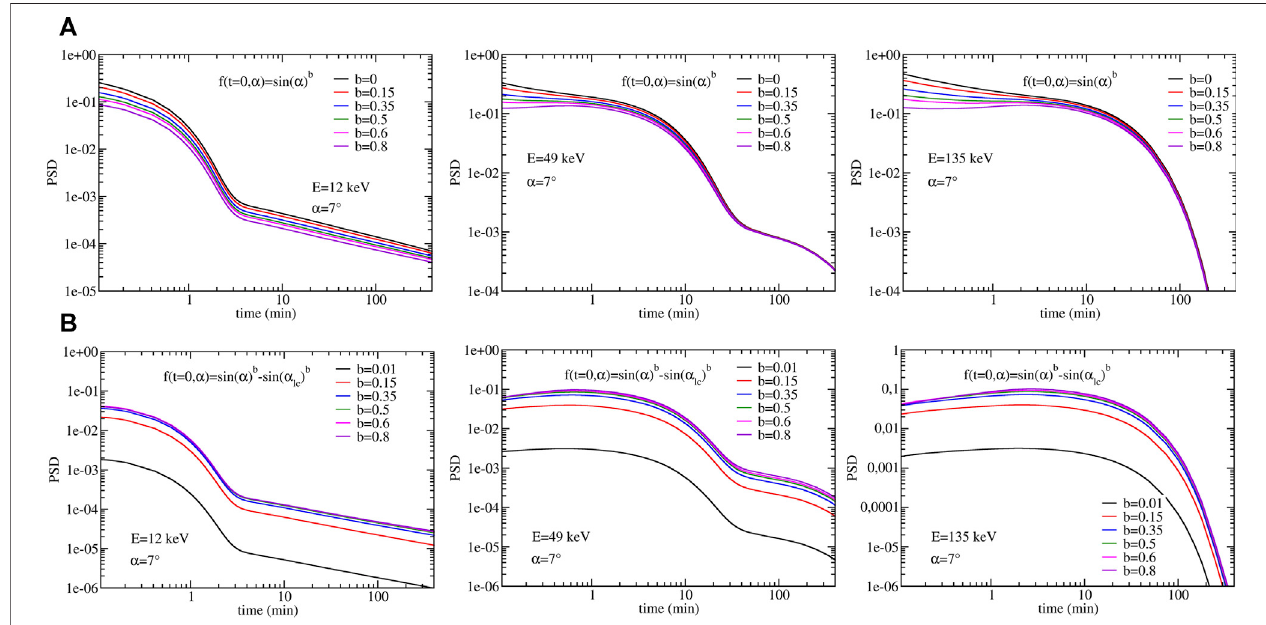
FIGURE 7 | Phase space density versus time for different initial conditions. Initial conditions without (A) and with (B) regularization at the loss cone for E (cid:1) 12, 49, and 135 keV.Within each plot, theinitial pitch angle distribution varieswithapower b ranging from b ∼ 0 (forwhichittends toward f ( t (cid:1) 0) (cid:1) 1) to b ∼ 1forwhich f ( t (cid:1) 0) (cid:1) sin( α ). For certain energies and b(E) power, the initial condition induces a growth of the PSD prior to a decaying phase. The decay itself presents various phases with different slopes. Changes of slope indicate the steady state has not been reached.